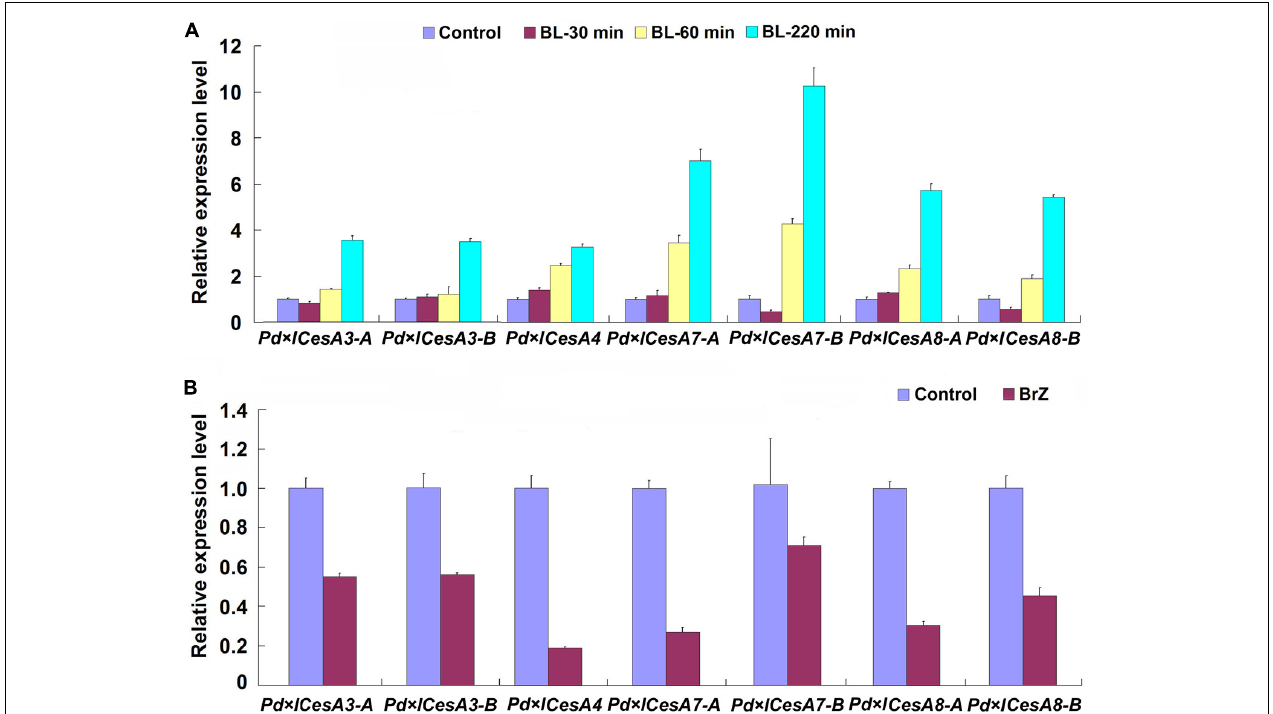
FIGURE 4 | qRT-PCR analyses of cellulose biosynthesis genes. Stems of wild type Shangxin yang plants were treated with 100 nM 2, 4-epibrassinolide (EBL) for 0, 30, 60, 220 min, or with 5 mM brassinazole (Brz) for 10 days, and the relative expressions of Pd × lCesAs were determined. (A) Expressions of Pd × lCesAs in the stems treated with EBL. (B) Expressions of Pd × lCesAs in the tension wood xylem tissues of the stems treated with Brz. The relative expression of Pd × lCesAs was normalized using the housekeeping gene Pd × lEF1 β . Gene expression value in the control was set to 1. Data were means ± SD ( n = 6) of three independent biological replicates with three technical replicates each. Gene Potri ID numbers were provided in Supplementary Table S1 .